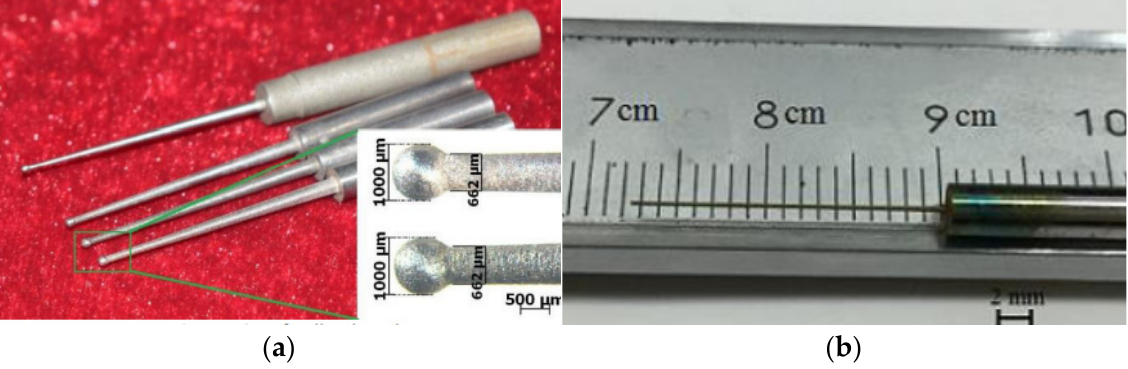
Figure 12. Cylindrical micro-parts fabricated by WTET process: ( a ) micro-bars; and ( b ) micro-pins (Reprinted/Adapted with permission from [65]. 2016, Elsevier. ©).